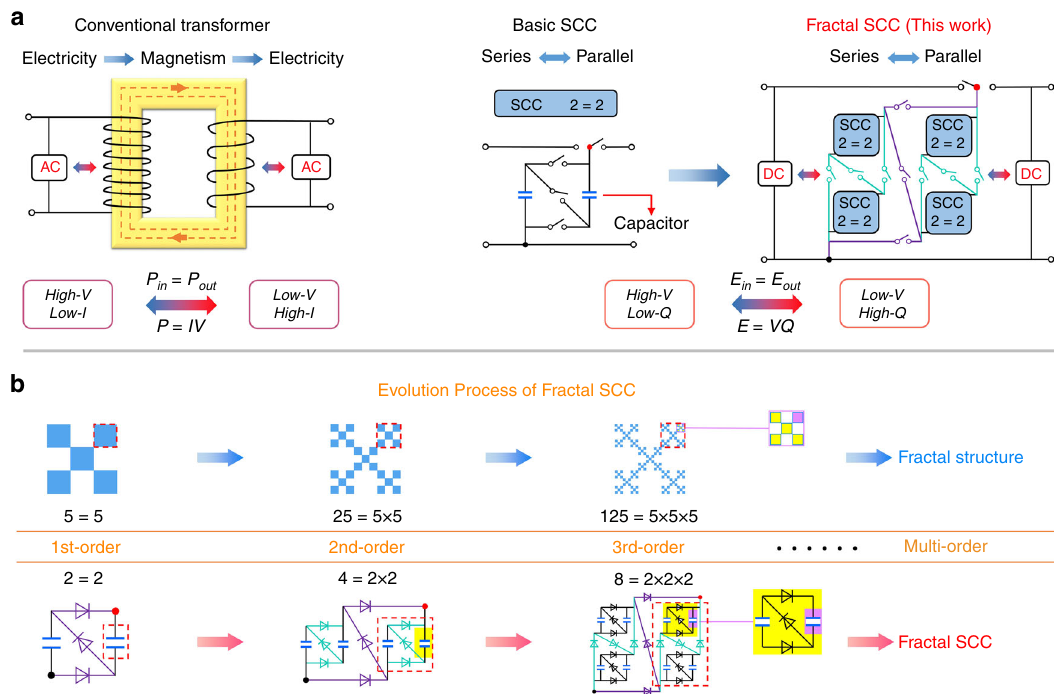
Fig. 1 Comparison of the two types of transformers. a The operating mechanism of a conventional electromagnetic transformer, a basic switched- capacitor convertor (SCC) and a fractal design based switched-capacitor-convertor (FSCC). b The concept of fractal structure evolution in order increasing and below it is the similar design based fractal structure evolution for FSCC in order increasing, which can be achieved by replacing capacitors in SCC repeatedly with 2 = 2 SCC